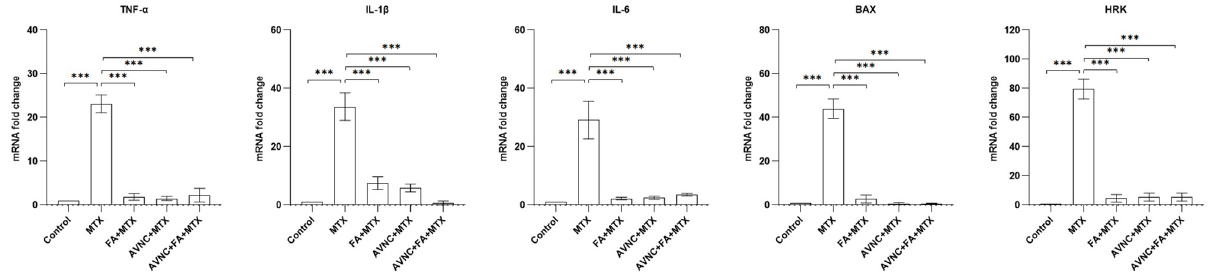
Fig 8. AVN-C and FA downregulate the apoptotic genes in HEI-OC1 cells of MTX-induced ototoxicity. The MTX ototoxicity model was established in vitro using HEI-OC1 cells. ROS- and apoptosis-related downstream genes such as TNF-a, IL1b, and IL6 were upregulated in the MTX- treated group. BAX, a death-inducing member, and HRK, an apoptosis activator, were highly upregulated in the MTX-treated group. However, either alone or in combination, AVN-C and FA significantly normalized the expression of these genes in HEI-OC1 cells. n = 3 (n represents triplicates) and ��� p < 0.001.